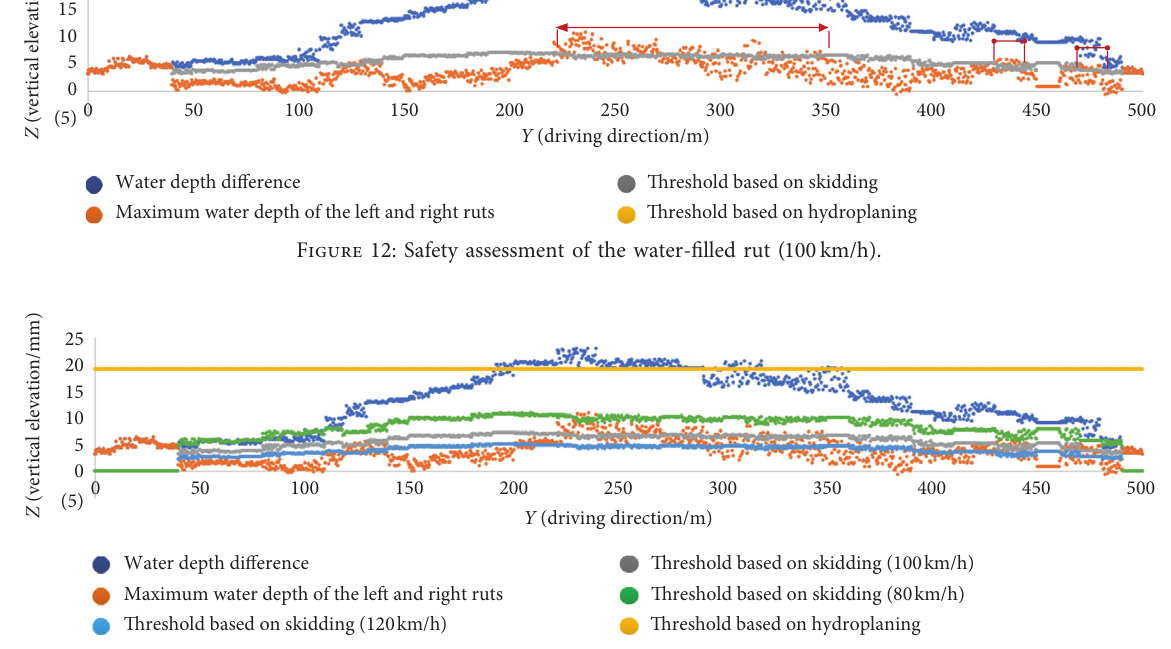
Figure 13: Safety risk assessment of the water-filled rut at different speeds (80, 100, and 120km/h). Table 3: Reduction in length of dangerous sections by decreased vehicle